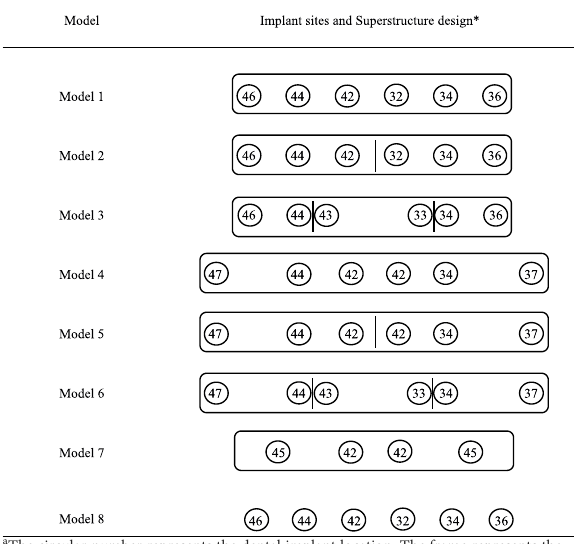
TABLE 3 Model design.